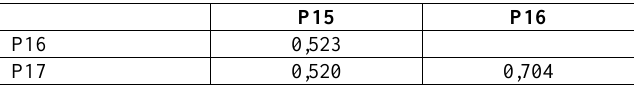
Figure 3: Relative weights of the Culture indicators The high correlation between C4, C8 and C9 indicates possibilities of aggregation into a single indicator.